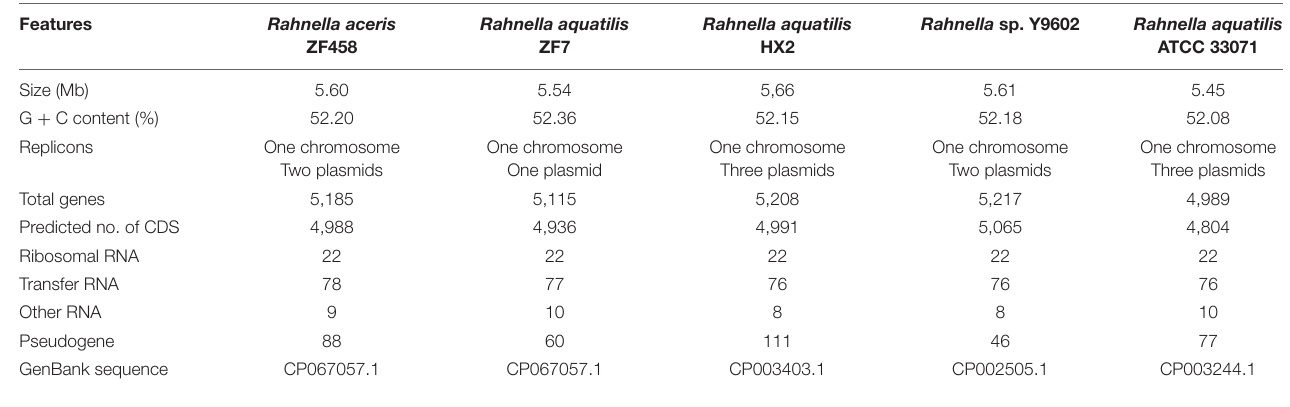
TABLE 2 | Genomic features of Rahnella aceris ZF458 and other Rahnella